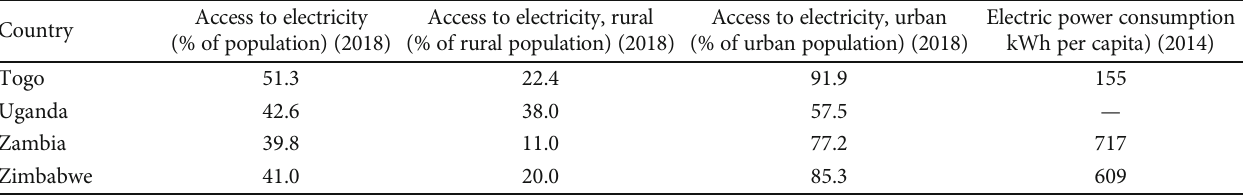
Table 6: Renewable energy targets for share of primary or fi nal energy of SSA, 2018, and progress, end-2016 [76]. Country